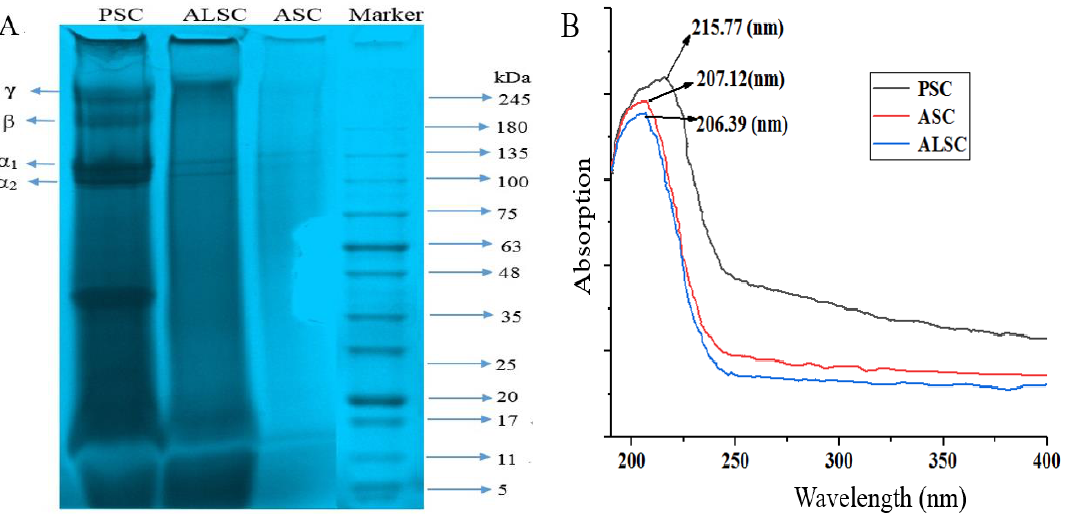
Figure 1. SDS-PAGE electrophoresis ( A ) and UV spectra ( B ) of ASC, ALSC, and PSC. Note: Since the UV scanning instrument can not export the original image, GetData software was used to take points and draw Figure